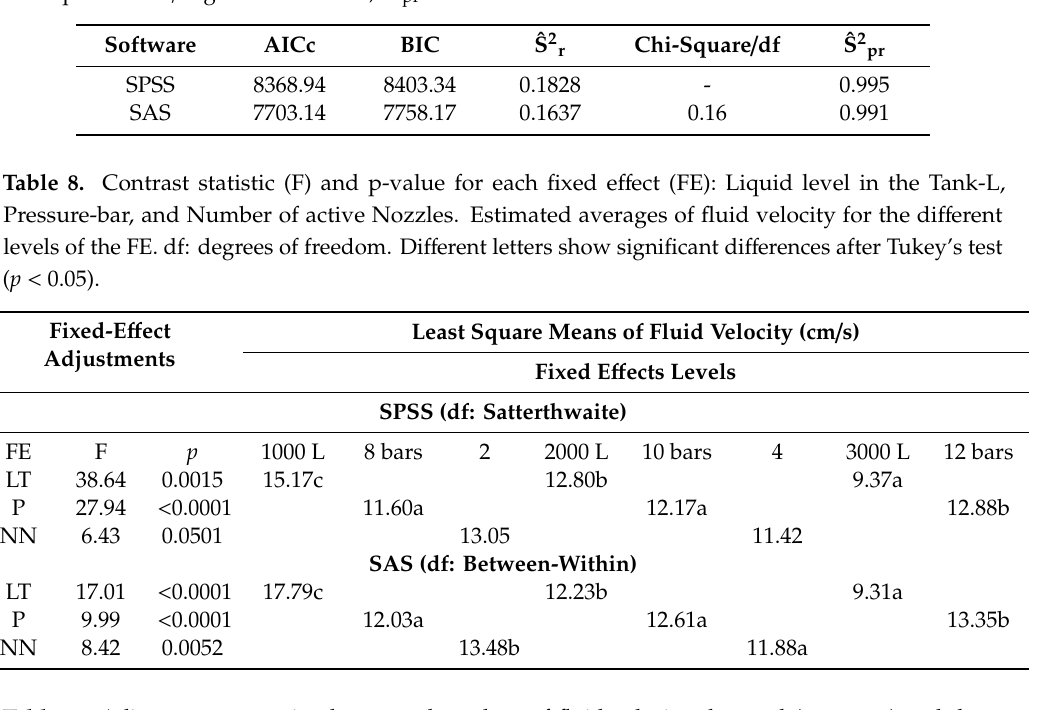
Table 9. Adjustment regression between the values of fluid velocity observed (regressor) and those predicted by the best model with SPSS and SAS software; intercept and slope of the equation. R 2 ad : adjusted determination coefficient. Rho: Spearman’s rank correlation coefficient. p -value its < 0.001 in all